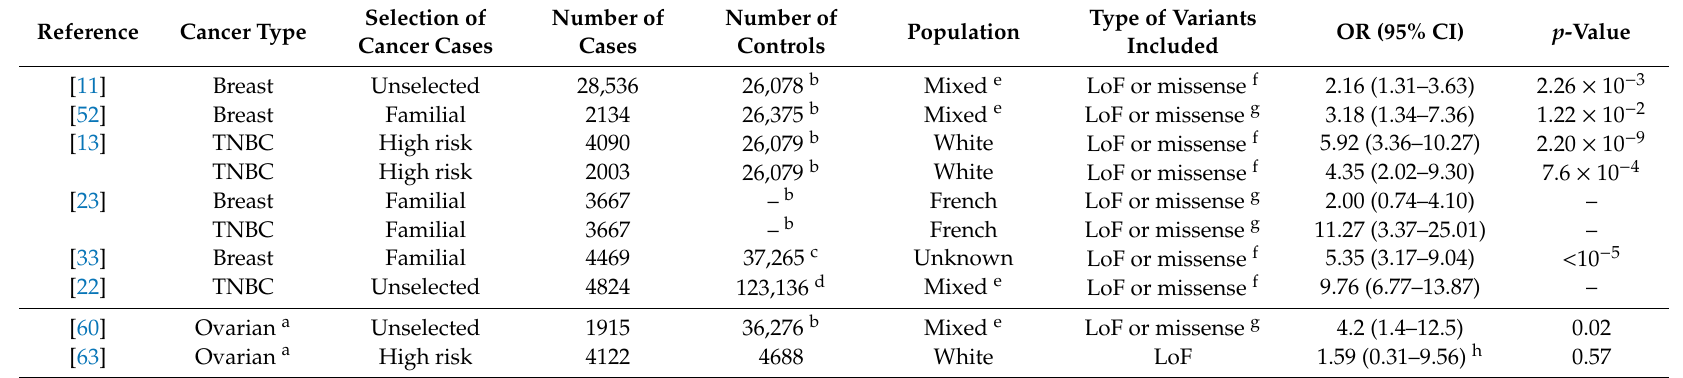
Table 1. Risk of breast or ovarian cancer associated with BARD1